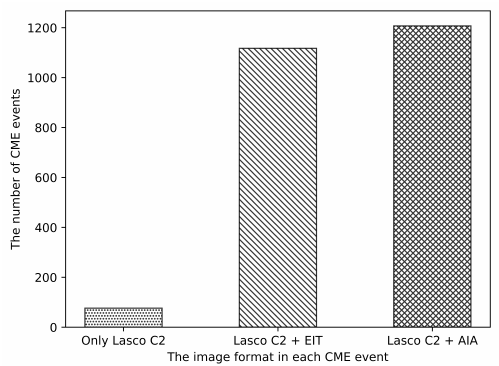
Figure 5. The distribution of different formats in CME events.